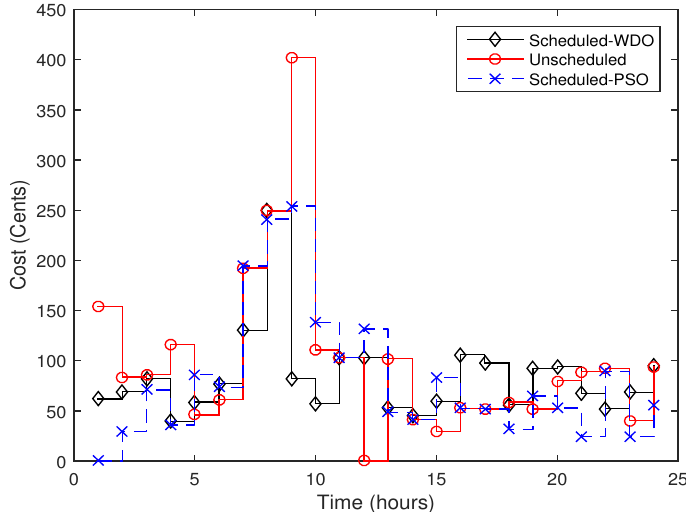
Figure 8. Electricity cost comparison of using the WDO and PSO algorithms.